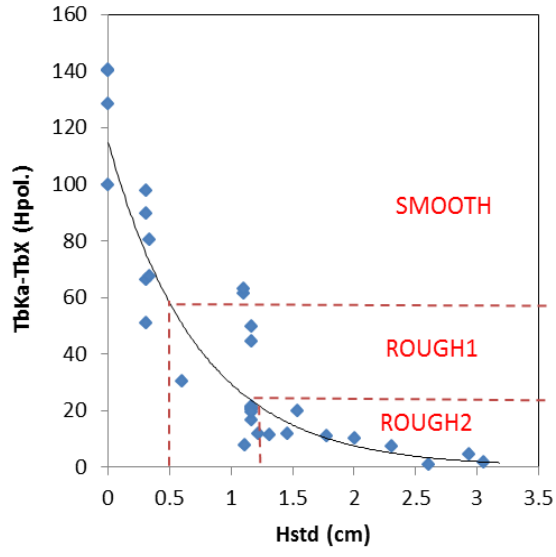
Figure 5. δ Tb = Tb Ka − Tb X at θ = 40 ◦ and H pol. as a function of Hstd (After Figure 5. δTb = Tb Ka − Tb X at  = 40° and H pol. as a function of Hstd (After [21]).